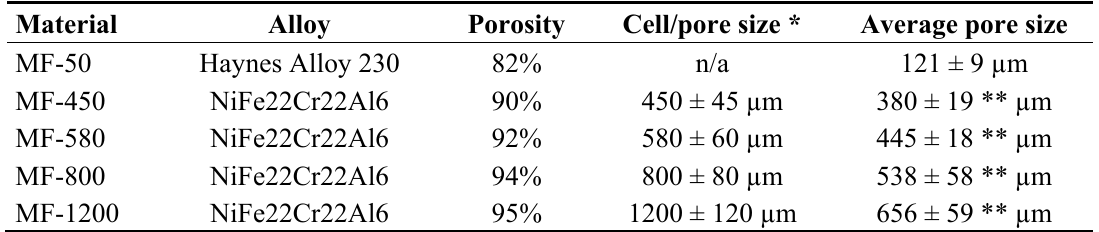
Table 1. Material properties of metal foams (MF), sintered flakes (SF), sintered spheres (SS) sintered fiber felts